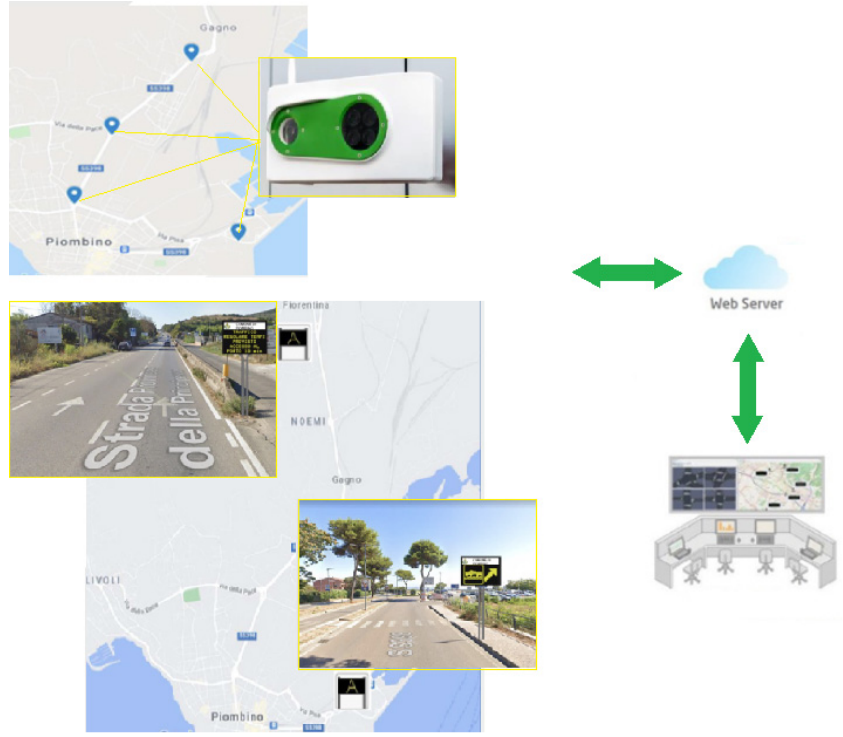
Figure 9. Representation and location of the ITS system implemented in Piombino.